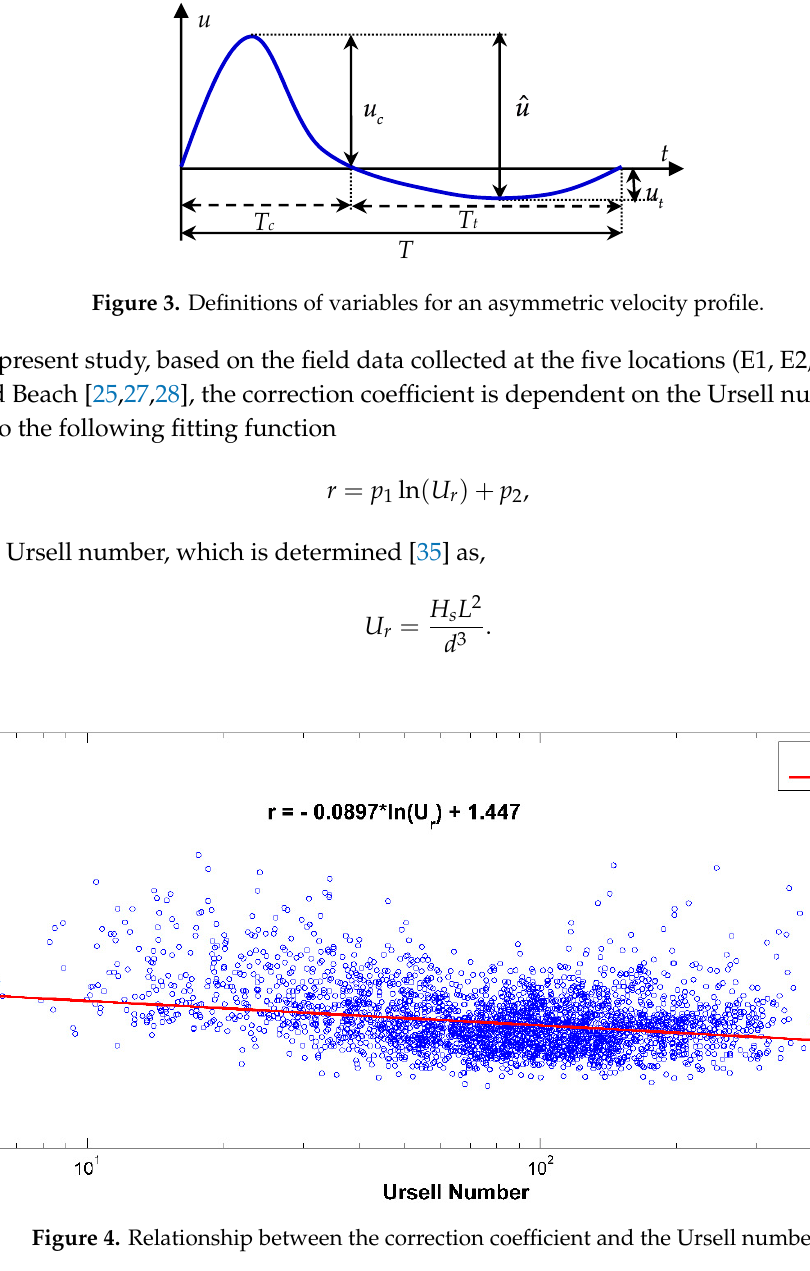
Figure 3. Definitions of variables for an asymmetric velocity profile.